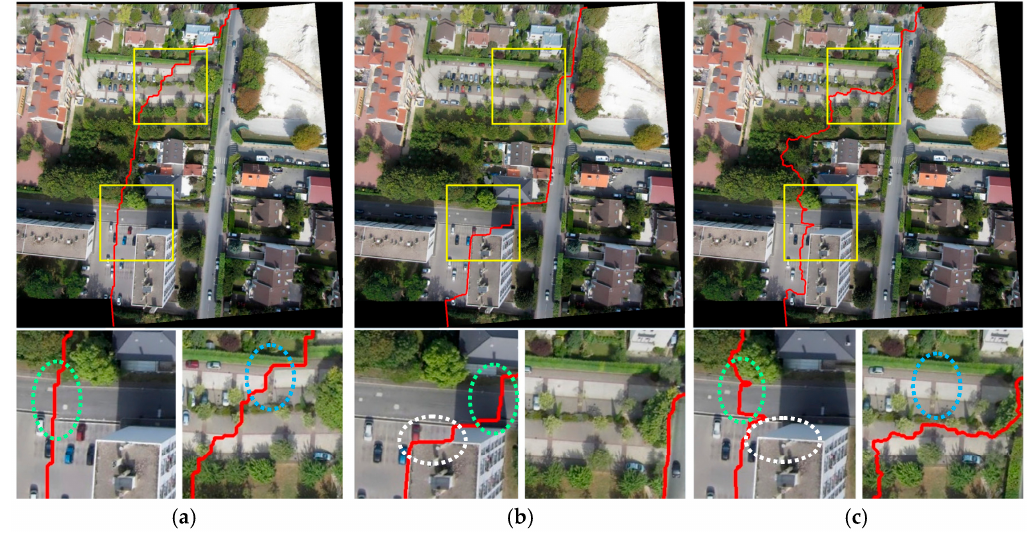
Figure 7. Optimal seam-lines of three test methods for Figure 5a. ( a ) GCC. ( b ) GCCG. ( c ) GCCGOF.